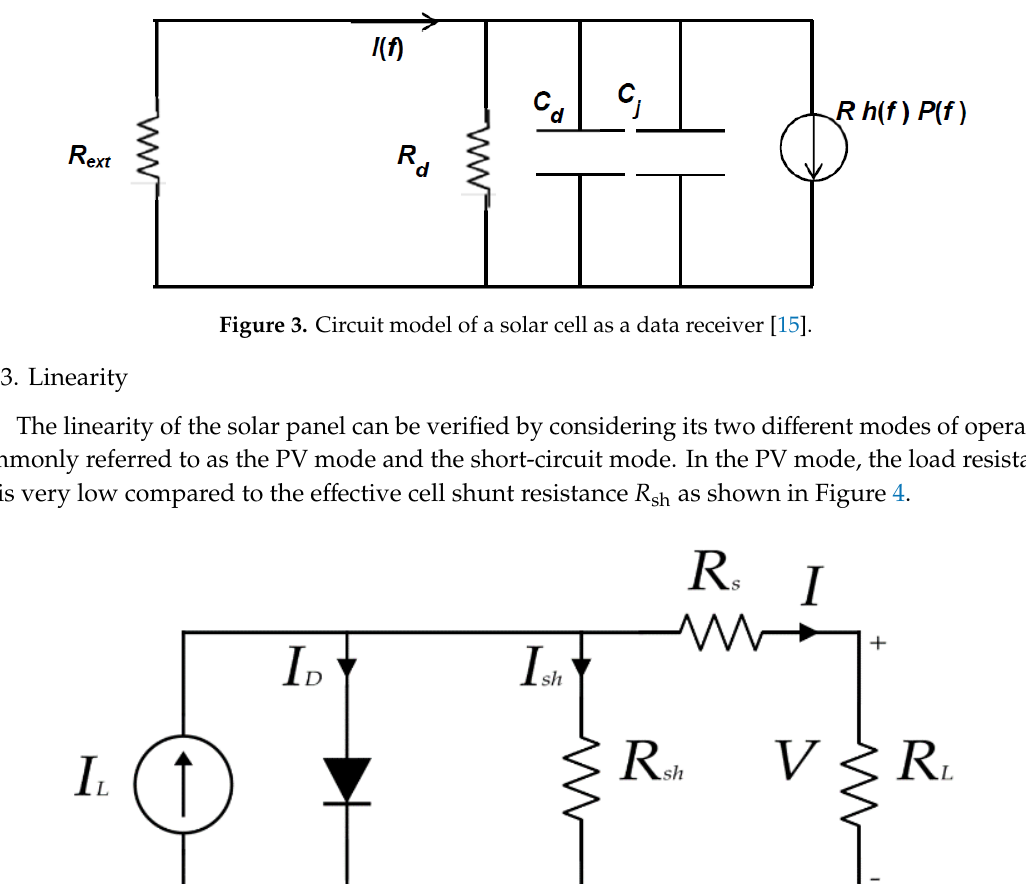
Figure 3. Circuit model of a solar cell as a data receiver [15].